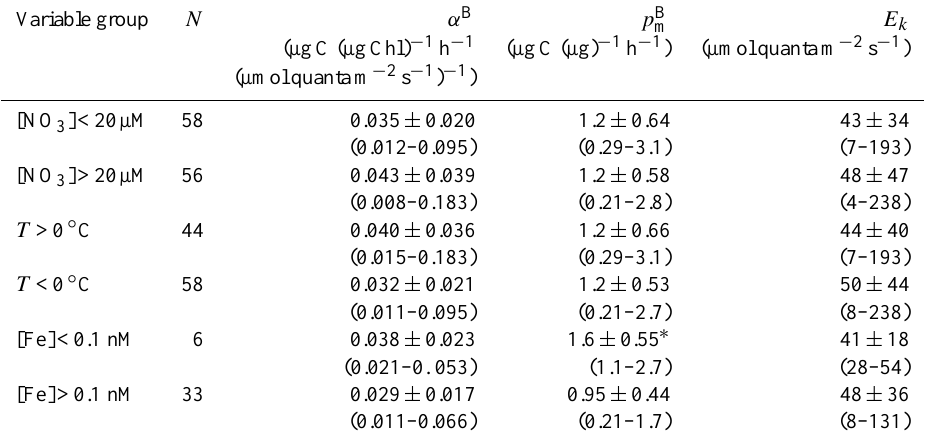
Table 3. Comparison of PRISM photosynthetic parameters as a function of nitrate, temperature, and iron (means and standard deviations). Range of data listed in parentheses. The available data were divided into those stations that had nitrate concentrations above and below 20µM, in situ temperatures above and below 0 ◦ C, and iron concentrations greater than or less than 0.1nM. No significant differences were noted between the two sets of parameters except where noted.